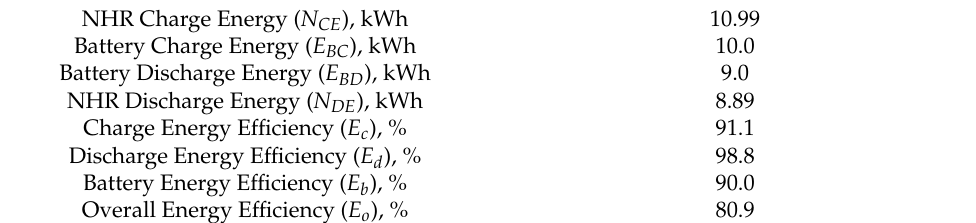
Table 2. Amount of energy and efficiencies of the charge and discharge